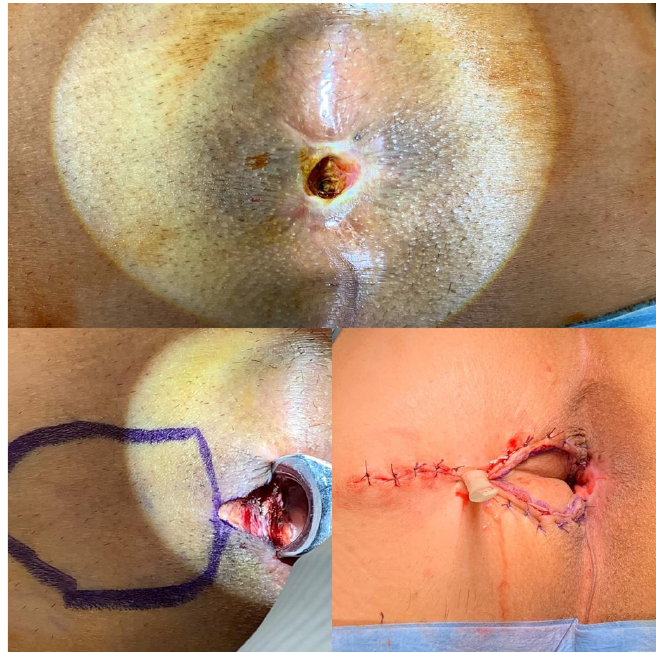
Figure 1. The house flap anoplasty is shown in a patient with severe anal stenosis.